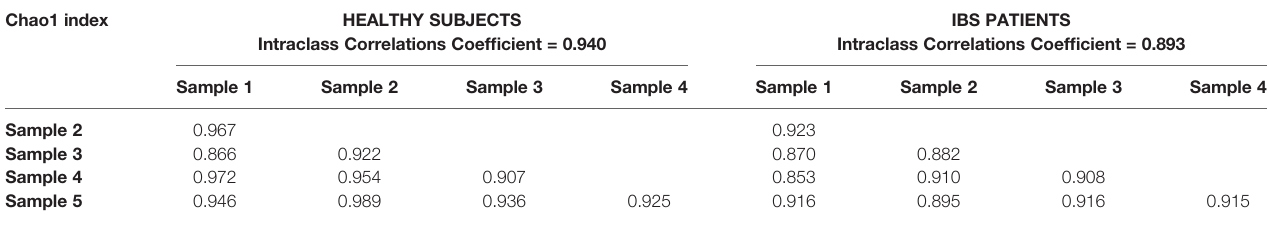
TABLE 2 | Inter-item (Pearson) correlations between Chao1-index of consecutive samples, for healthy subjects and IBS patients. Chao1 index